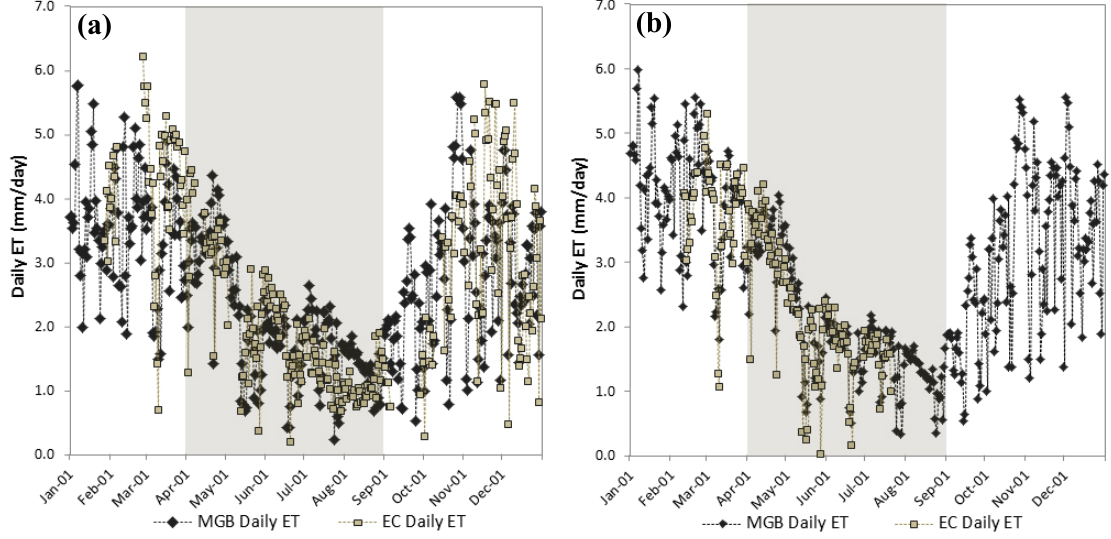
Figure 7. Daily evapotranspiration estimated from the MGB-IPH hydrological model compared with in situ eddy covariance measured data at the PDG site ( a ) and USE site ( b ). The climatological dry season is